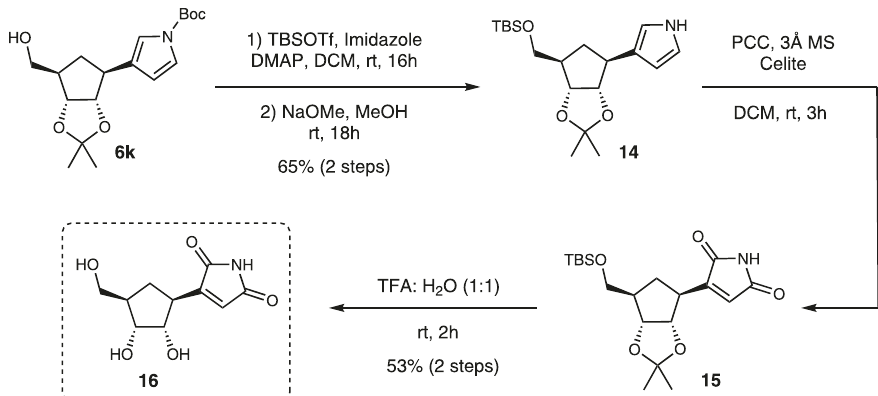
Fig. 9 Synthesis of carbocyclic Showdomycin. Post-synthetic modi fi cation of Pyrrole to access carbocyclic analog of